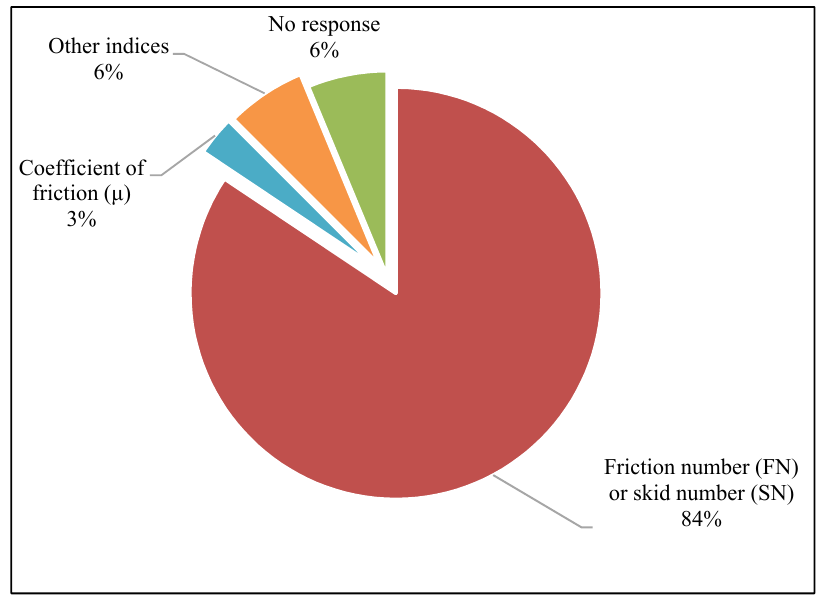
Figure 5. Pavement friction indices commonly used by state DOTs.